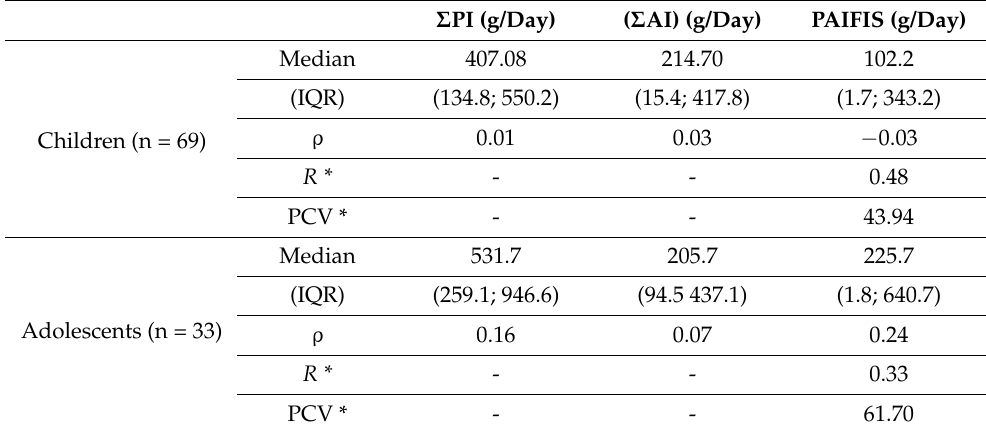
Table 5. Validity criterion of the PAIFIS in grams per day with hs-CRP in a sub-sample of the SAYCARE